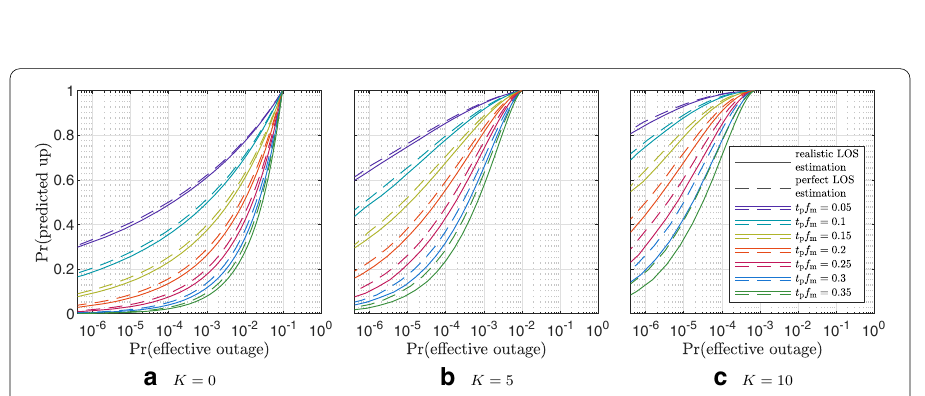
Fig. 16 Analysis of the outage prediction performance. 10 dB SNR, F = 10dB , (cid:31) tf m = 0.05 , M = 25 and N =